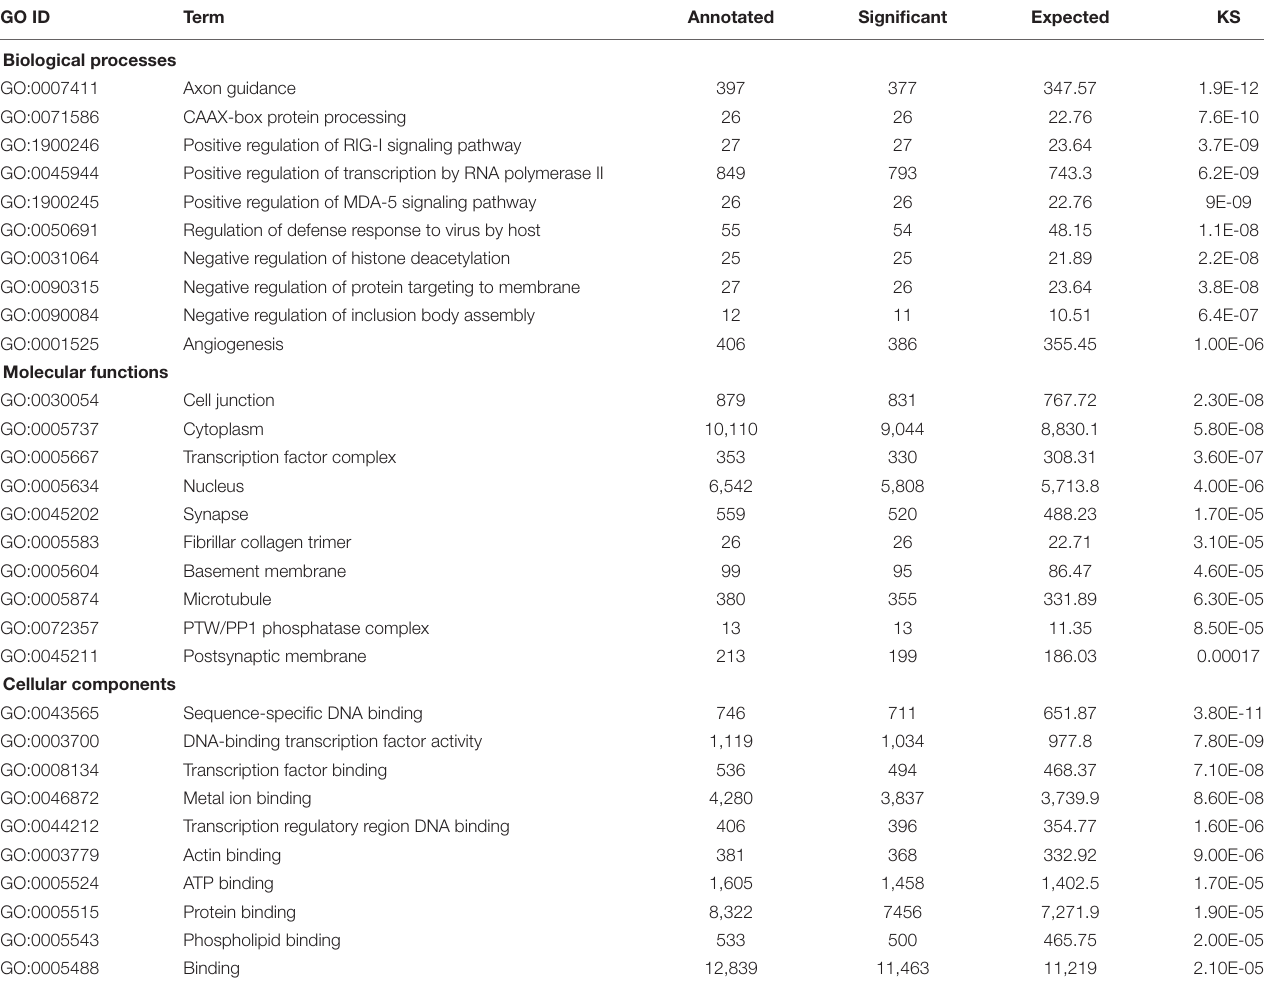
TABLE 1 | Top 10 most significantly enriched GO categories of the differentially expressed